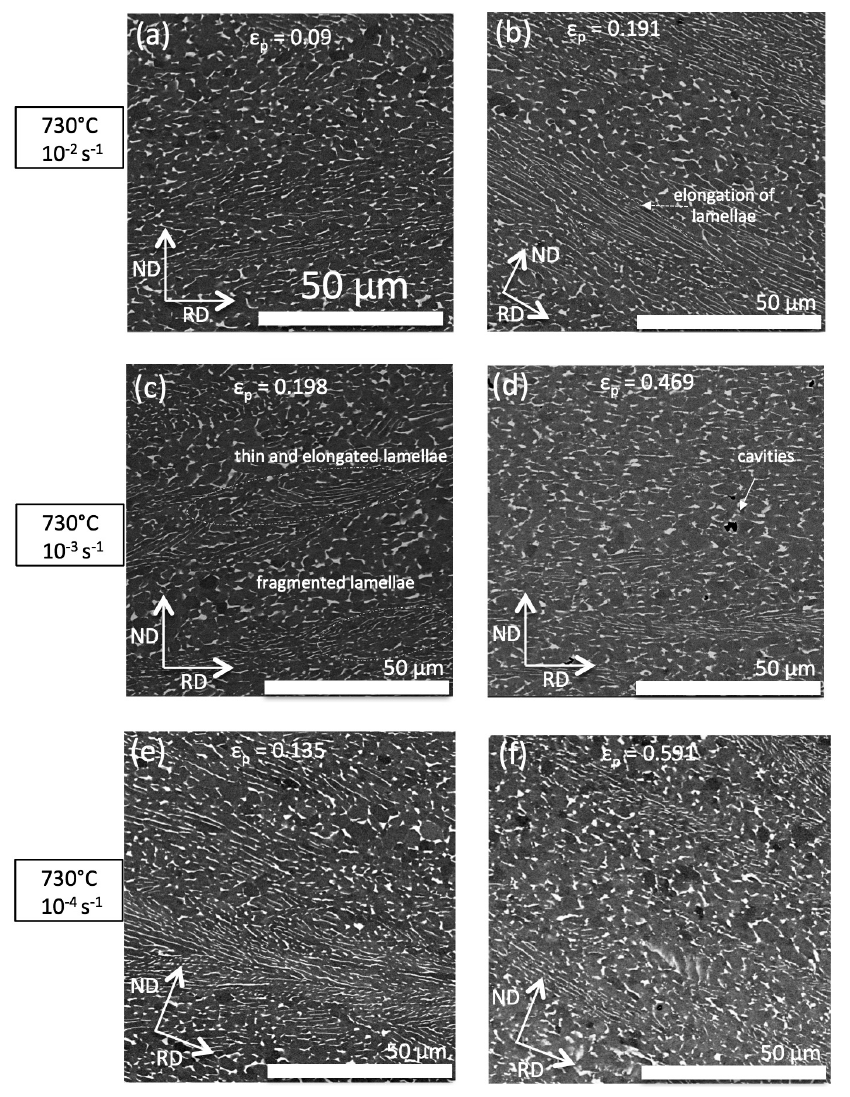
Figure 4. SEM-BSE images showing the evolution of the microstructure of the Ti6242 alloy during deformation at 730 ◦ C for several elongations and strain rates: 10 − 2 s − 1 ( a , b ); 10 − 3 s − 1 ( c , d ); 10 − 4 s − 1 ( e , f ). At higher temperature (840 ◦ C), these softening mechanisms that can counteract the initial strain hardening (due to increase of entangled dislocations), occur at a lower critical strain. Note that this critical strain also decreases with decreasing the strain